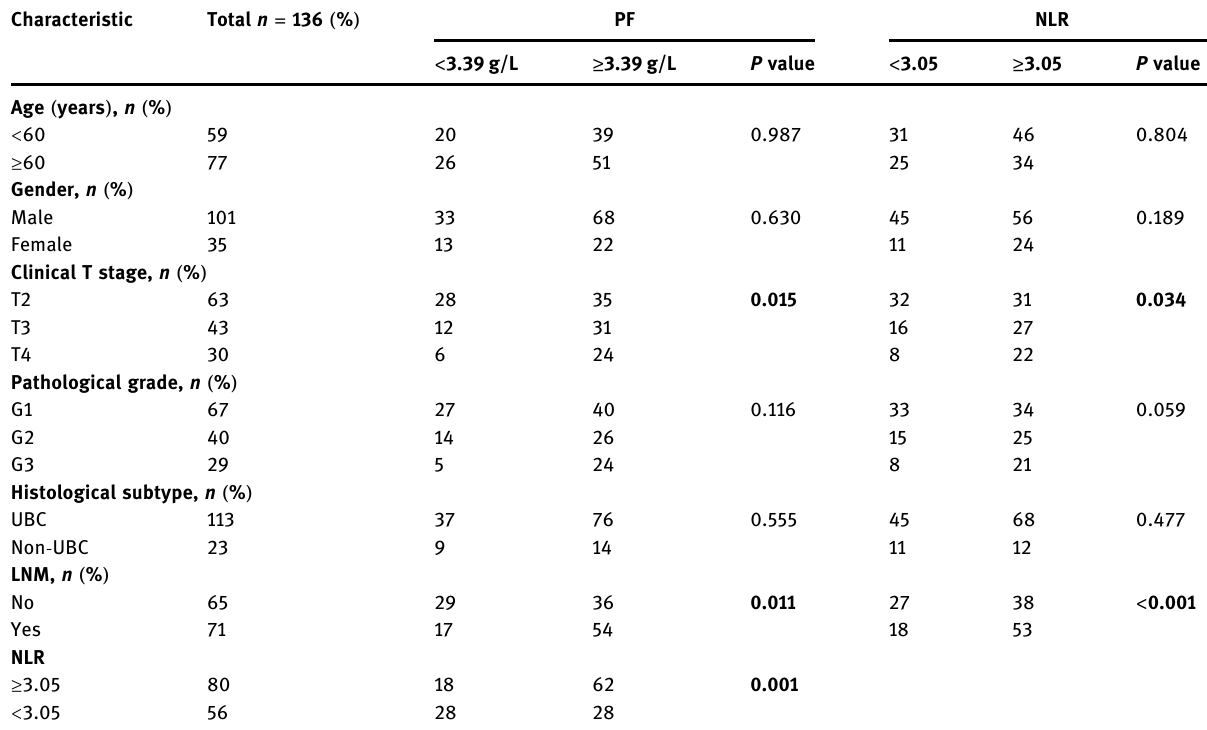
Table 3: Clinicopathological features of 136 BC undergoing RC patients strati fi ed by PF and NLR